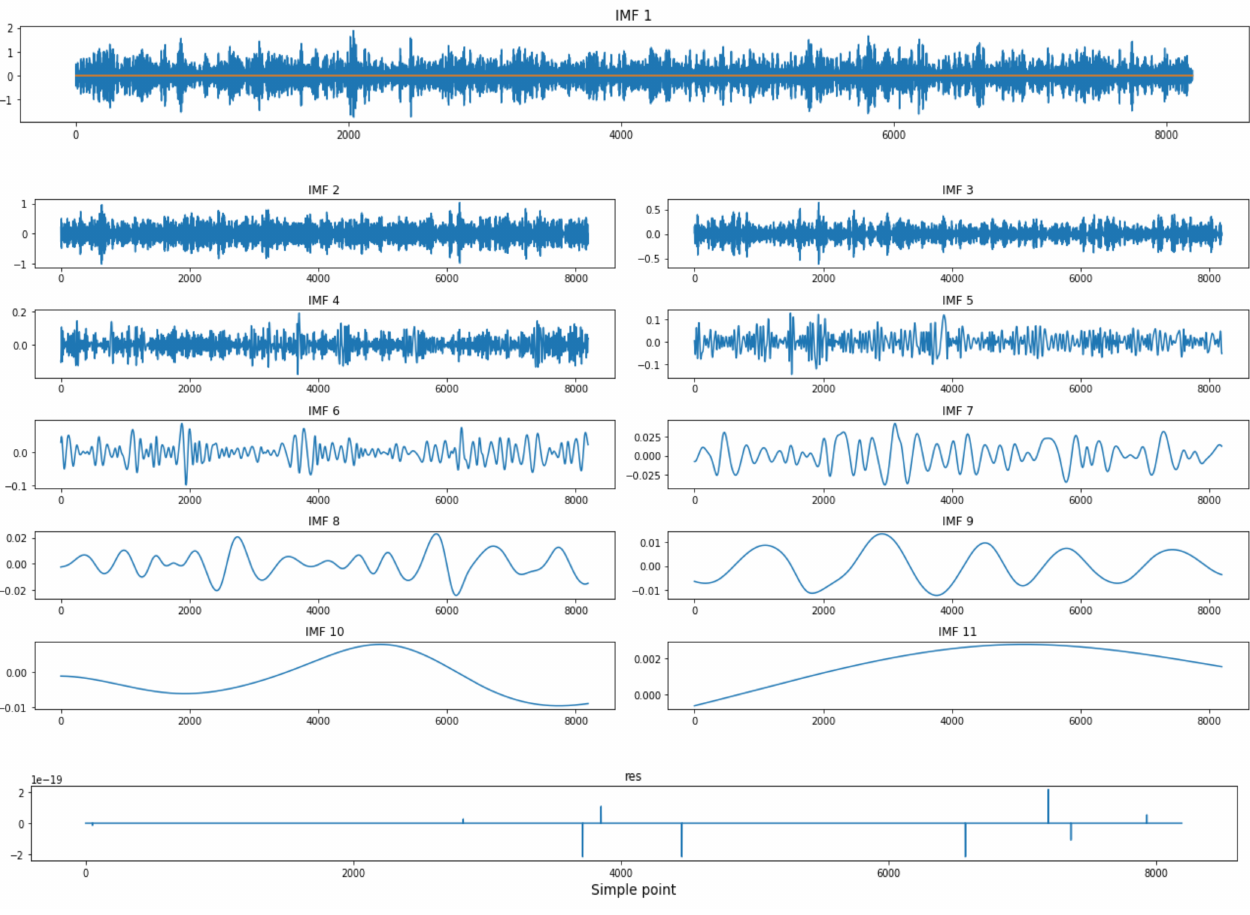
Figure 9. Results of decomposition for A_1 acceleration data